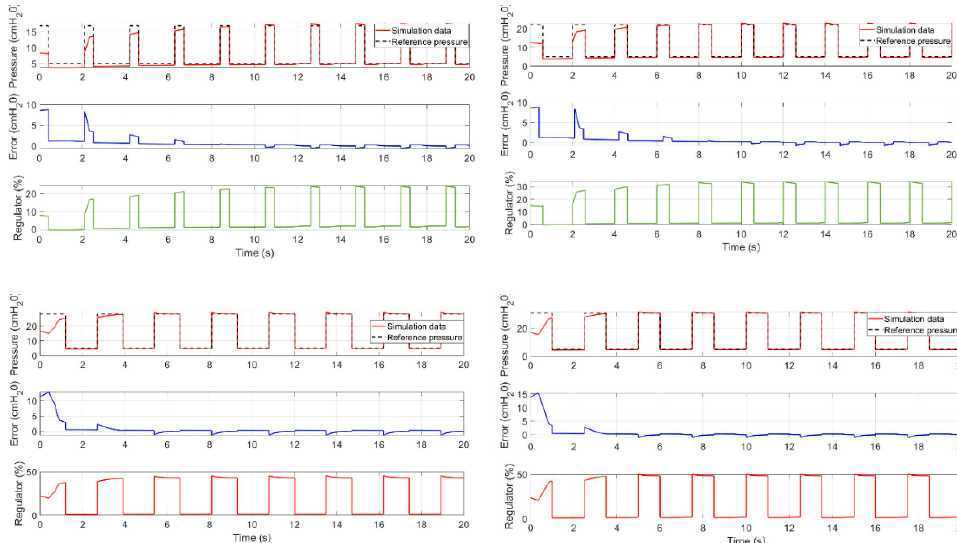
Figure 22. Simulation results. Top left: reference pressure 17 cm H 2 O, inspiration time t i = 0.42 s, expiration time t e = 1.675 s. Top right: reference pressure 22 cm H 2 O, inspiration time t i = 0.6 s, expiration time t e = 1.395 s. Bottom left: reference pressure 28 cm H 2 O, inspiration time t i = 1.215 s, expiration time t e = 1.48 s. Bottom right: reference pressure 31 cm H 2 O, inspiration time t i = 1 s, expiration time t e = 1.495 s.